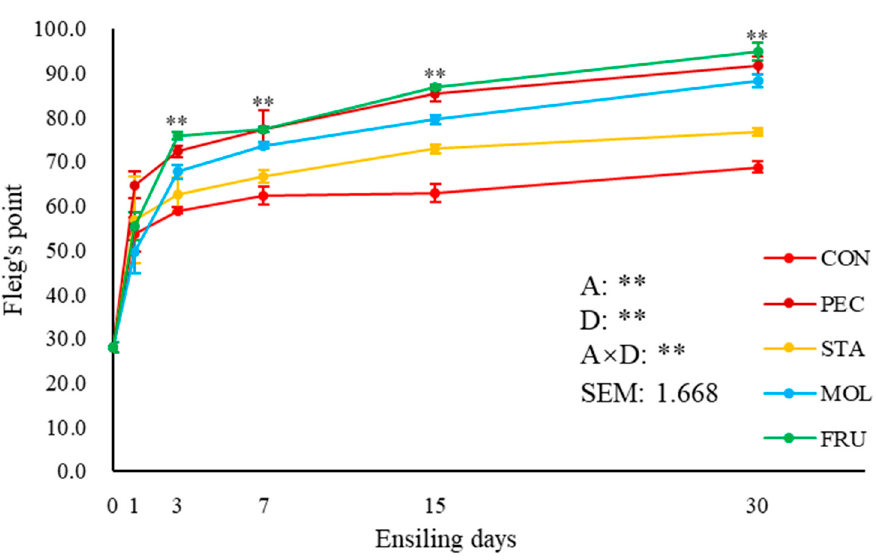
Figure 3. Effect of additives on the Fleig’s point during ensiling of alfalfa. CON, control; PEC, pectin; STA, starch; MOL, molasses; FRU, fructose. A denotes significance of additives; D, denotes significance of ensiling days; A × D denotes the interactive effect between additives and ensiling days. SEM, standard error of means. The asterisks (** p ≤ 0.01) indicate the significance of additives and ensiling days and their interaction effects, and the difference at the specified ensiling